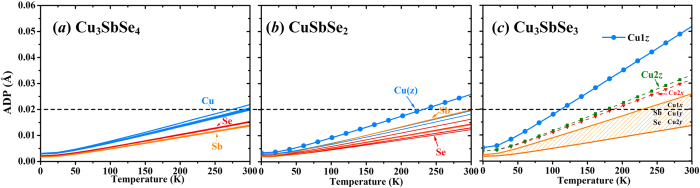
Calculated atomic displacement parameters (ADP) for three compounds.For (c) Cu3SbSe3, the ADPs for Sb, Se, Cu2y, Cu1x, and Cu1y are within the belt region. The dashed line is for a guide for the eye.